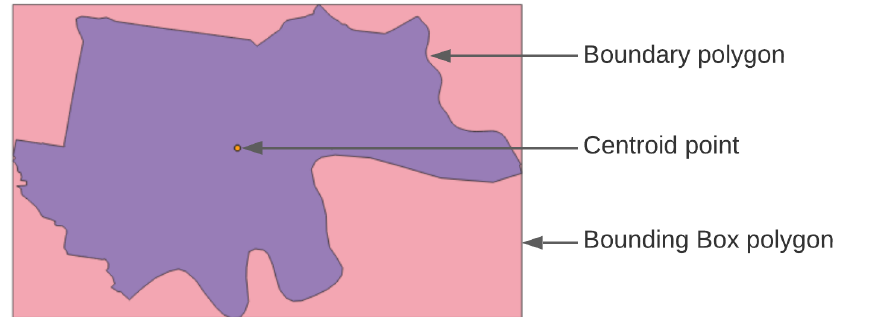
Figure 3. Geometries of the Australian federal electoral district of Brisbane. GeoSPARQL 1.0 contained only the property geo:hasGeometry to indicate a geo:Geometry instance for a geo:Feature instance. GeoSPARQL 1.1 contains the specialised properties of geo:hasCentroid & geo:hasBoundingBox which can indicate geometries with particular roles. See Listing 2 for an RDF representation of this figure’s